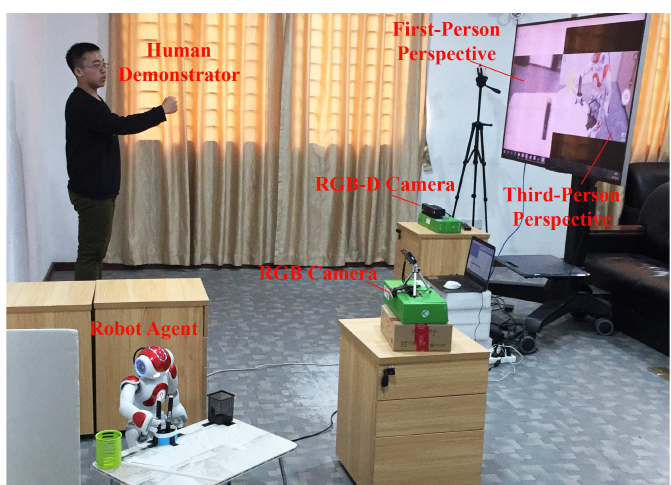
Figure 17. The real-time imitation system used in the task-oriented teleoperation experiment. In the experiment, the robot imitated a series of motions performed by the human demonstrator and successfully placed the pens into the containers. A–H in Figure 19 show snapshots of the motions of the human and the robot during the process of placing the blue pen into the right green container. I–P in Figure 19 show snapshots of the motions of the human and the robot during the process of placing the pink pen into the left black container.